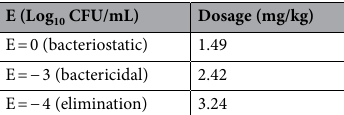
Table 6. Different dosages were calculated respectively based on AUC 24h /MIC ratio for bacteriostatic, bactericidal and bacterial eradication.